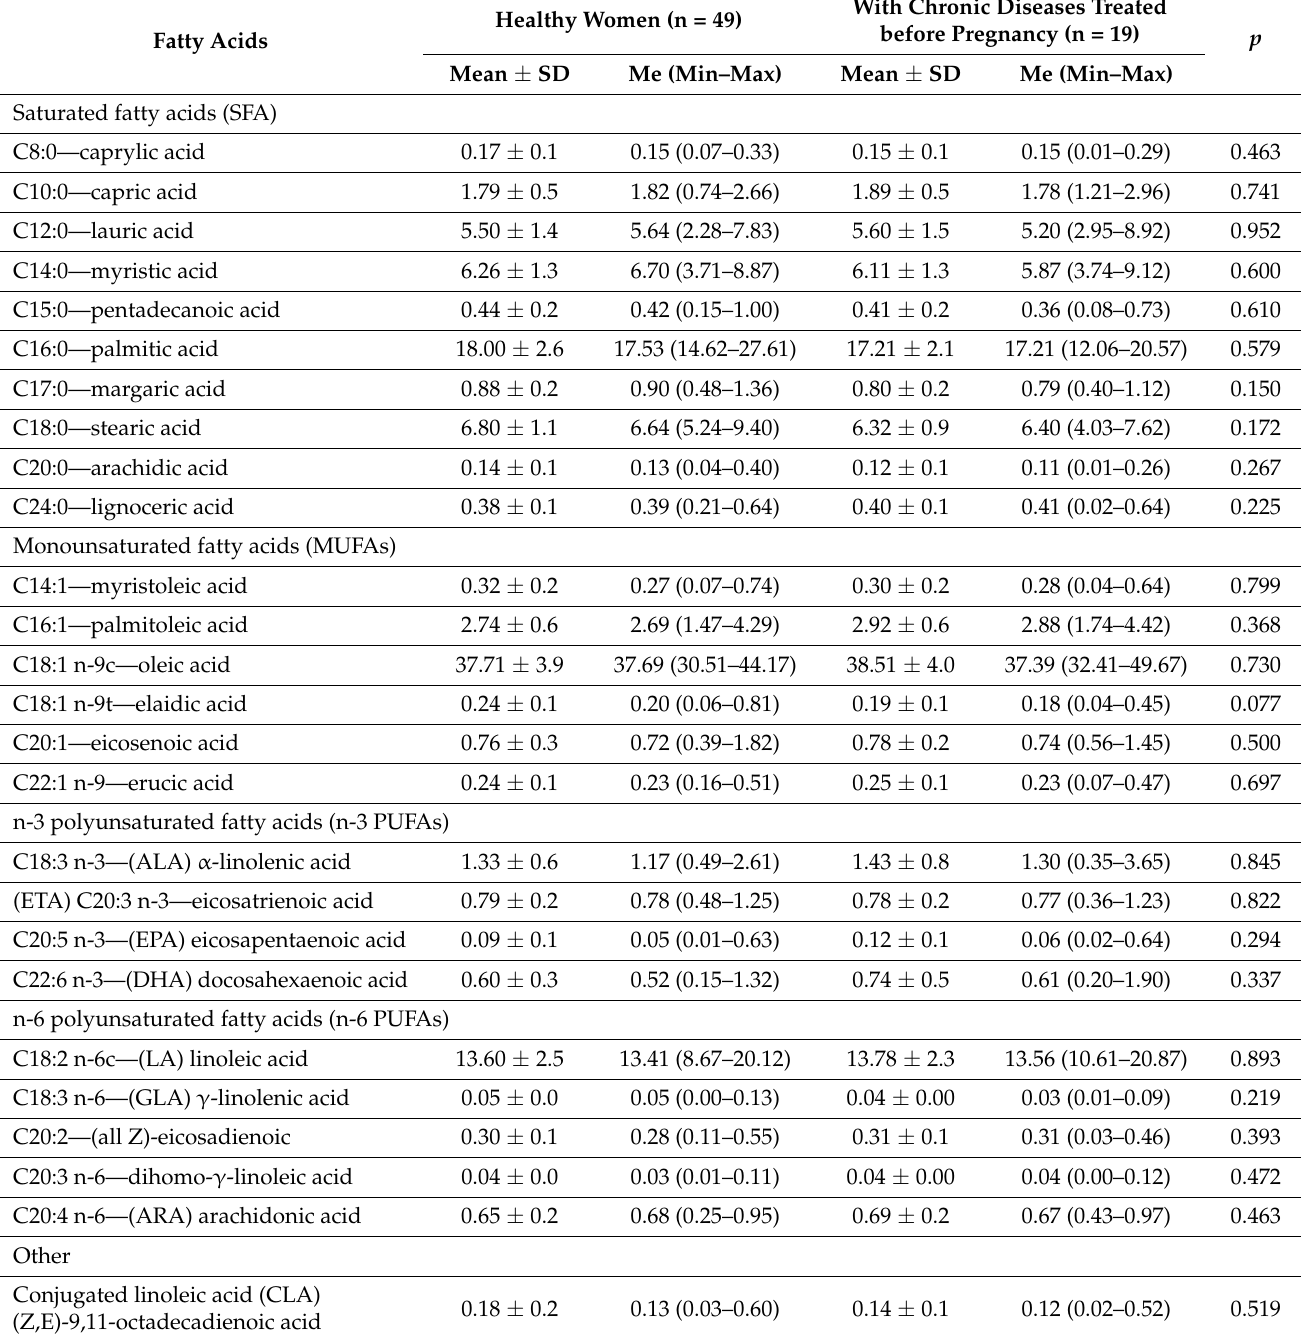
Table 8. Fatty acid content of breast milk (g/100 g of total FA) depending on